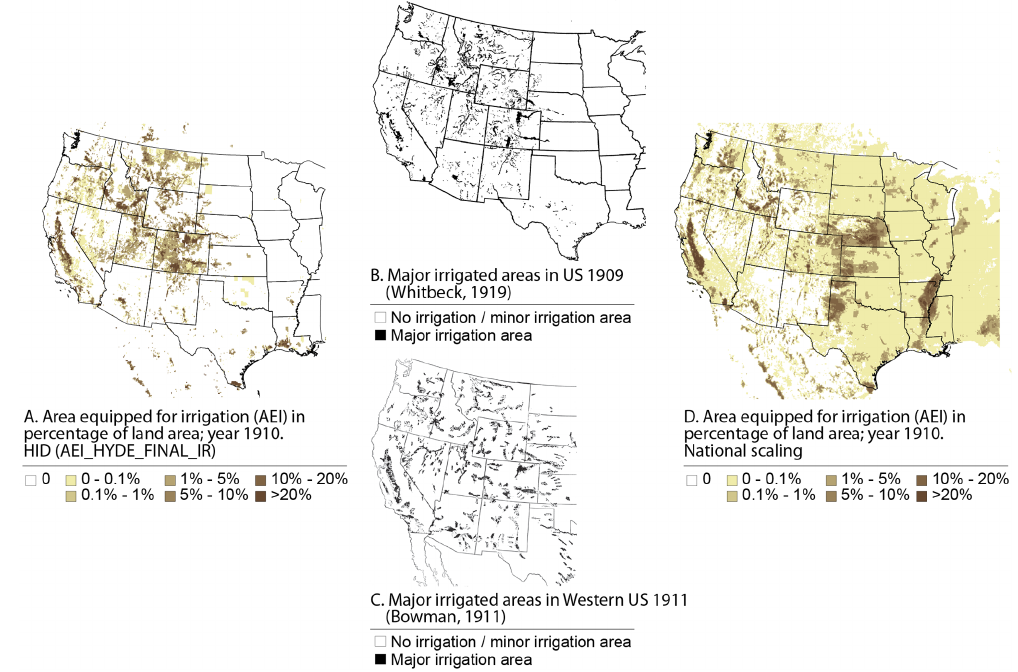
Figure 6. Comparison of the historical irrigation data set (HID) for year 1910 (developed using HYDE land cover, central estimate; AEI_HYDE_FINAL_IR) (a) with a map showing irrigated area in the western part of the USA in year 1909 (Whitbeck, 1919) (b) , a map showing irrigated area in the western part of the USA in year 1911 (Bowman, 1911) (c) , and an irrigation map for year 1910 developed by multiplying area equipped for irrigation (AEI) in year 2005 with scaling factors derived from historical changes of AEI at country level (d)